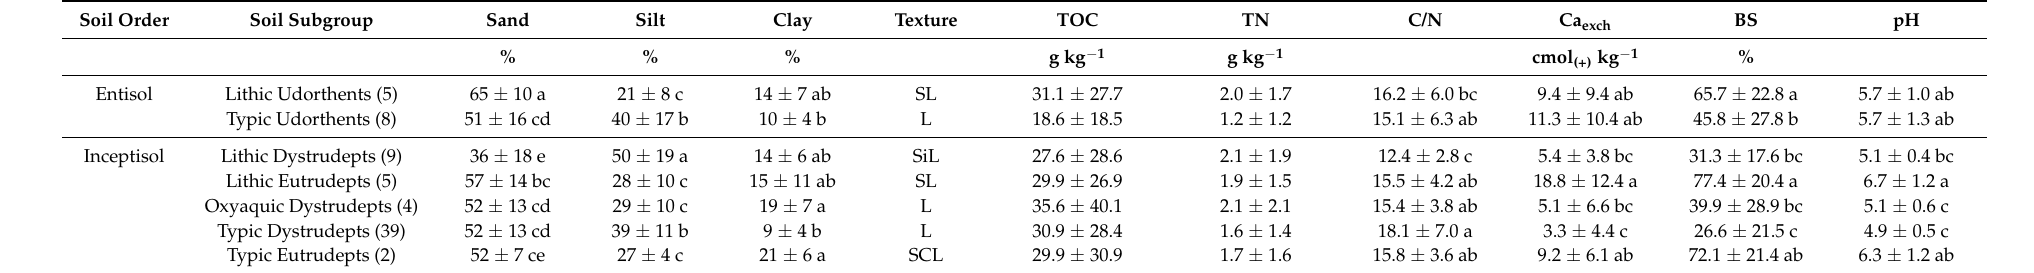
Table 3. Mean ± standard deviation of sand, silt, clay, total organic carbon (TOC), total nitrogen (TN), and exchangeable Ca (Ca exch ) contents, base saturation (BS), and pH values, and texture class of soils identified at 400–1000 m above sea level and classified according to Soil Survey Staff [52]. Round brackets identify the number of soil profiles for each soil type. Within each column, different letters indicate significant differences among the values (Kruskal–Wallis test, p < 0.05). Sand Silt Clay Texture TOC TN